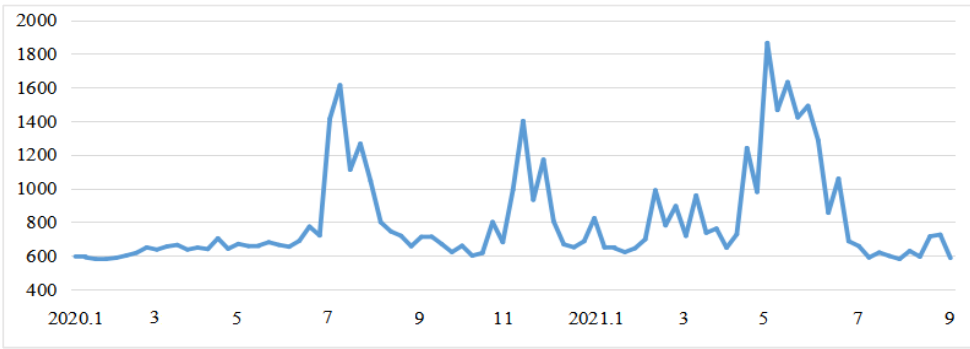
Figure 2. Number of Weibo comments before and after policy implementation.